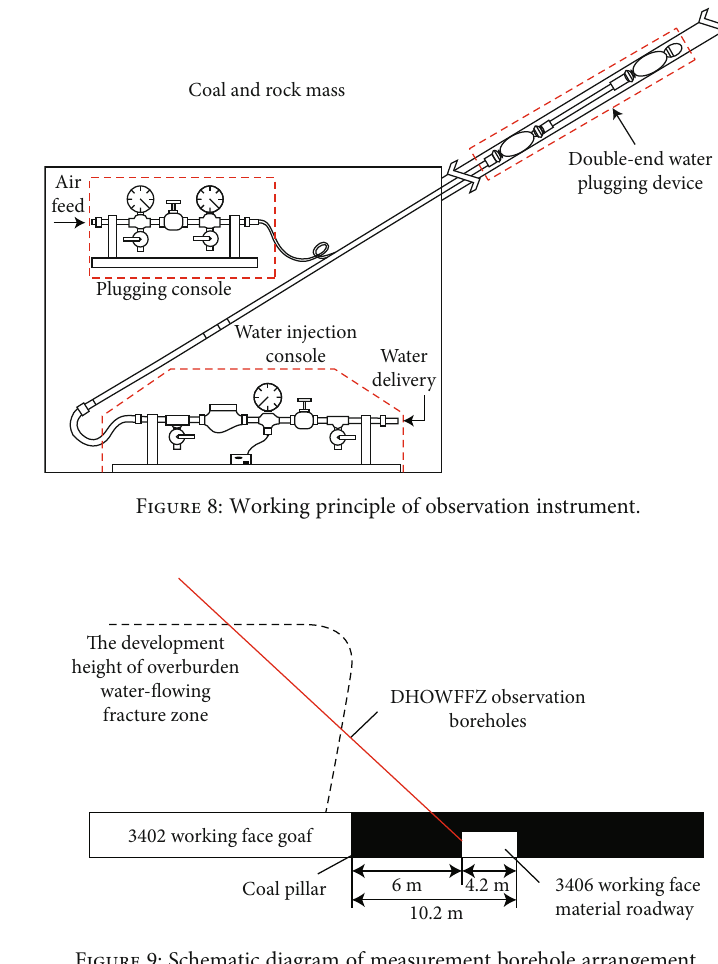
Figure 9: Schematic diagram of measurement borehole